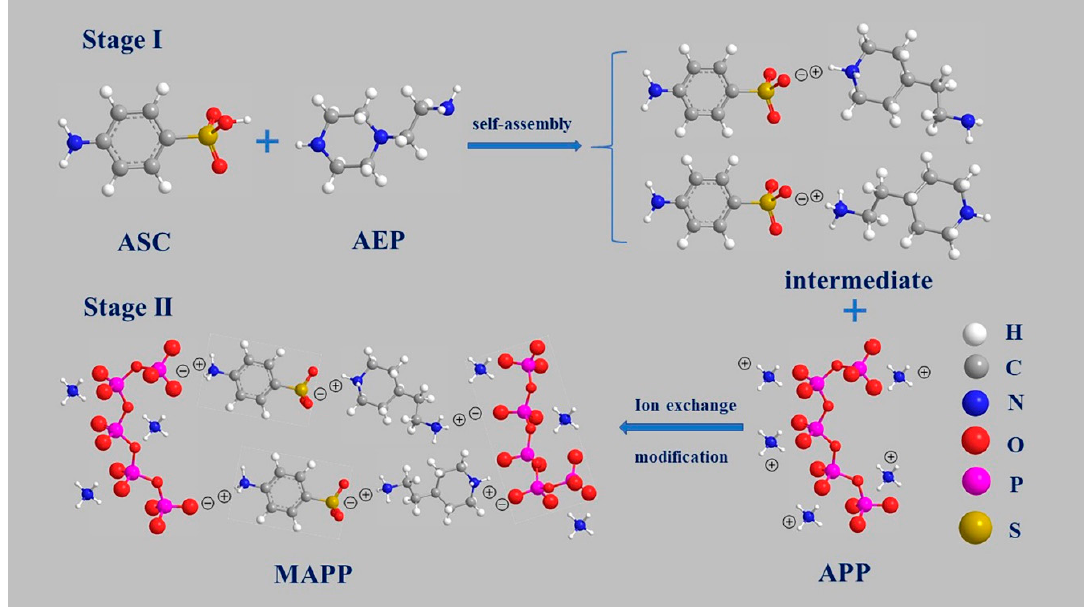
Figure 1. The synthetic route of MAPP.